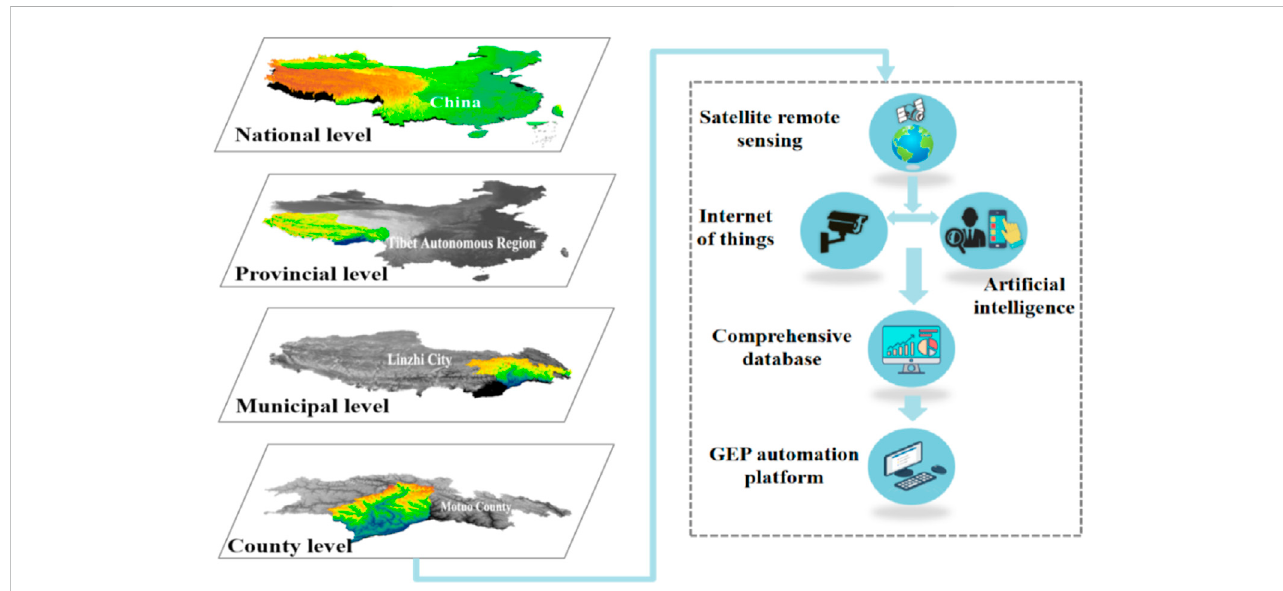
FIGURE 7 ChinaGEPworksystempathmodel.Nationallevel:mainlycarryoutoverallplanning,policyguidanceandtransferpayment;Provinciallevel:mainlycarry out capital investment, ecological value evaluation and fi nancial reward and subsidy; Municipal level: mainly engaged in fi nancial credit, government procurement and market development; County level: mainly engaged in infrastructure construction and ecological product development. Through the exploration of the pilot demonstration system at the provincial, municipal and county levels, and using scienti fi c and technological means, promote the establishment of GEP accounting automation platform and ecological product spatial information data resource database.